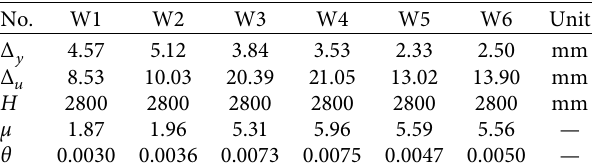
Table 7: Ductility coefficient and shift angle of specimens.